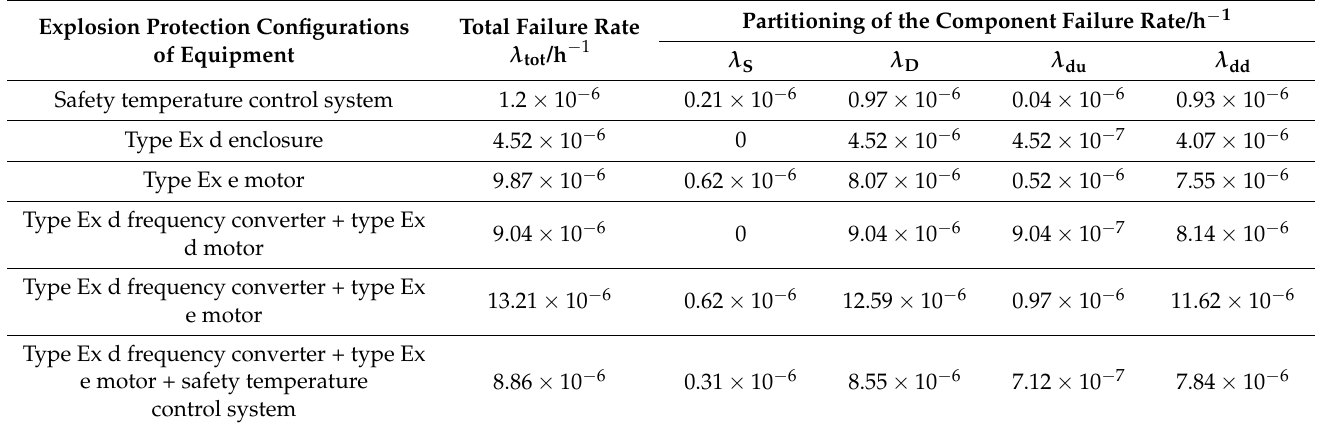
Table 12. Failure rates of different explosion-proof VFD systems.